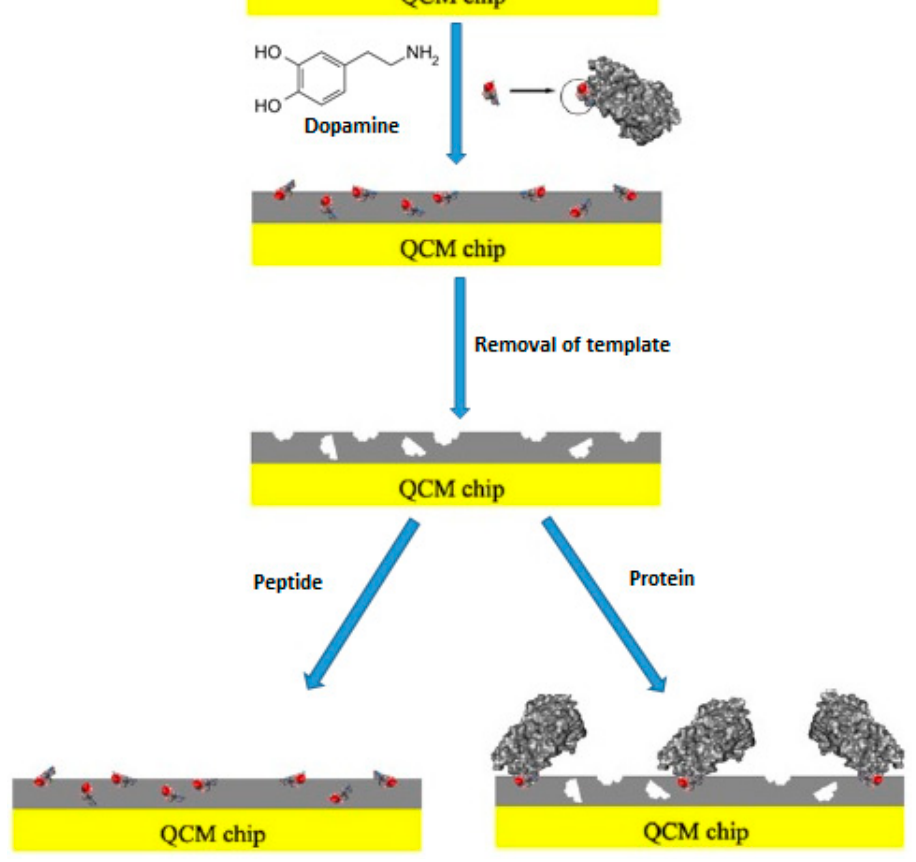
Figure 4. Schematic representation of epitope-imprinting (reproduced with permission from [20]).